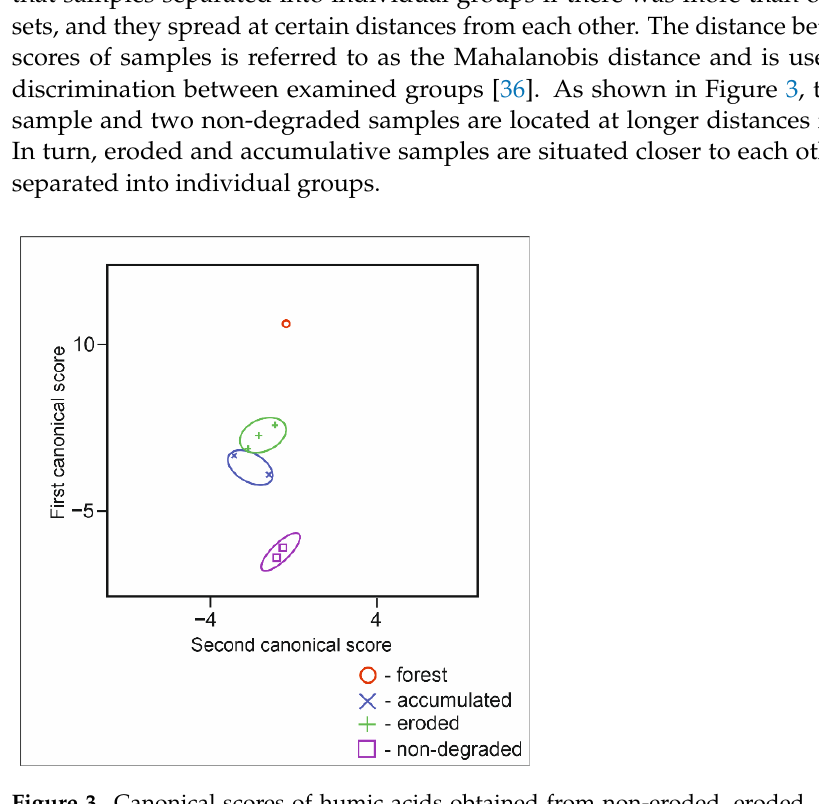
Figure 3. Canonical scores of humic acids obtained from non-eroded, eroded, accumulated and forest soils.